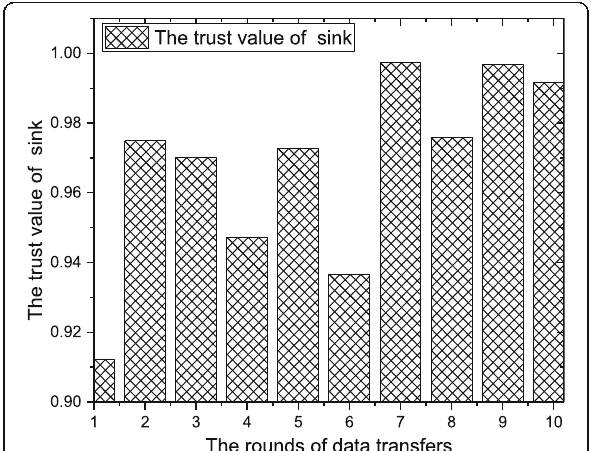
Fig. 9 Trust value of sink after 10 rounds of data